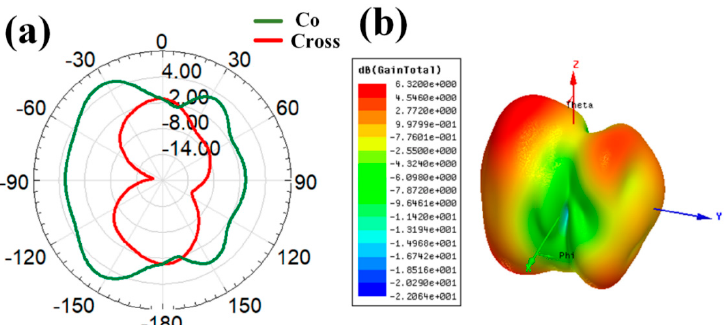
Figure 4. Directivity response for the Type-1 antenna under the consideration of port-1 as an exciting port. ( a ) 2D response of directivity with co- and cross-polarization. ( b ) 3D directivity response.